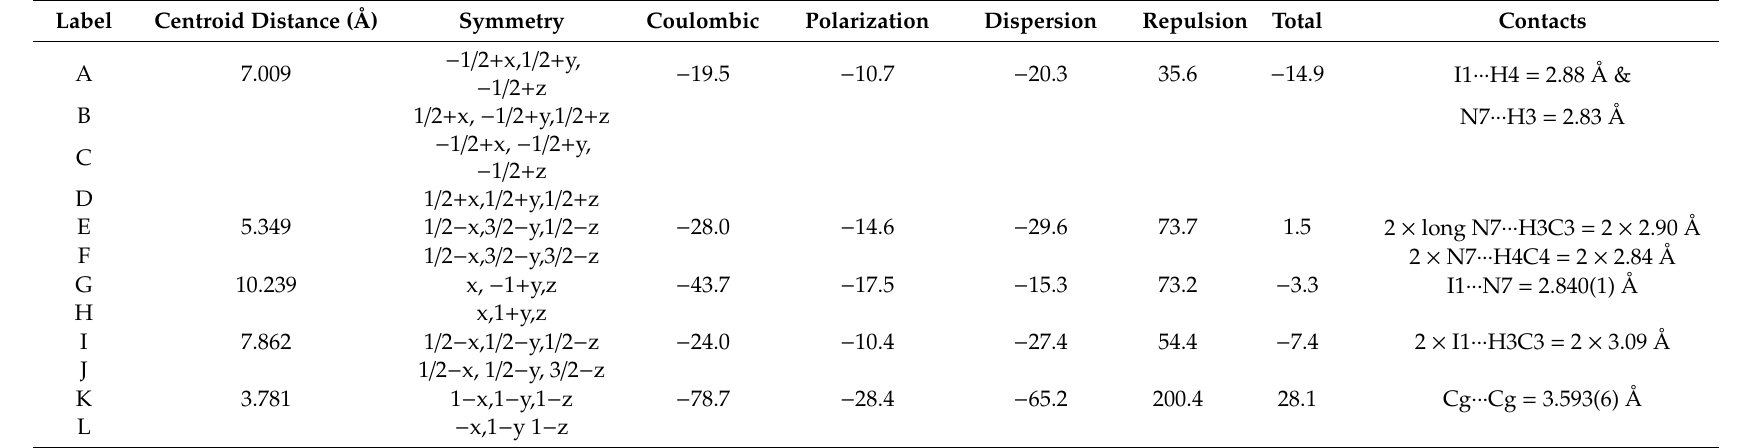
Table 2. PIXEL calculated dimer interaction energies of the phase I polymorph at 5.0 GPa, immediately below the phase transition. All energies are in kJ mol − 1